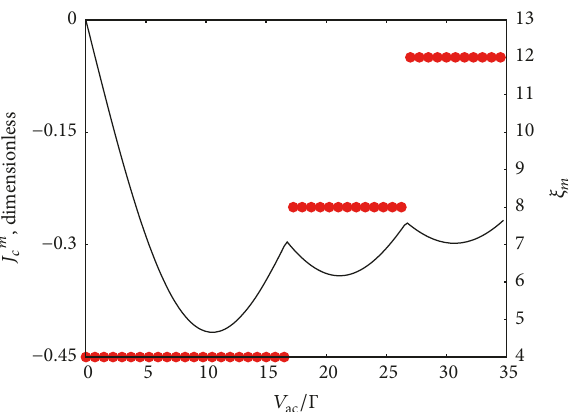
Figure 7: Maximum absolute value of the negative active current 𝐽 𝑐𝑚 (solid line, left 𝑦 -axis) and its position relative to the energy of the resonant level 𝜉 𝑚 = (𝜀 − 𝜀 𝑅 )/Γ (red circles, right 𝑦 -axis) as a function of amplitude of the AC electric field in the model with monoenergetic electrons at the frequency ℏ𝜔 = 4Γ .